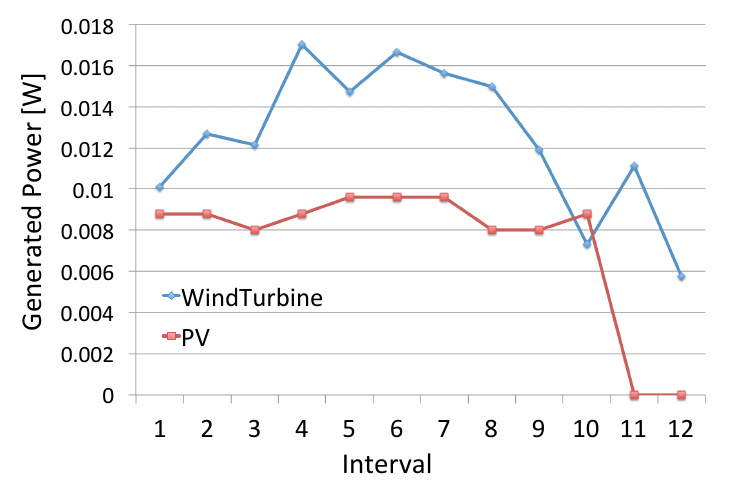
Figure 20. The transition of the power supply from the distributed